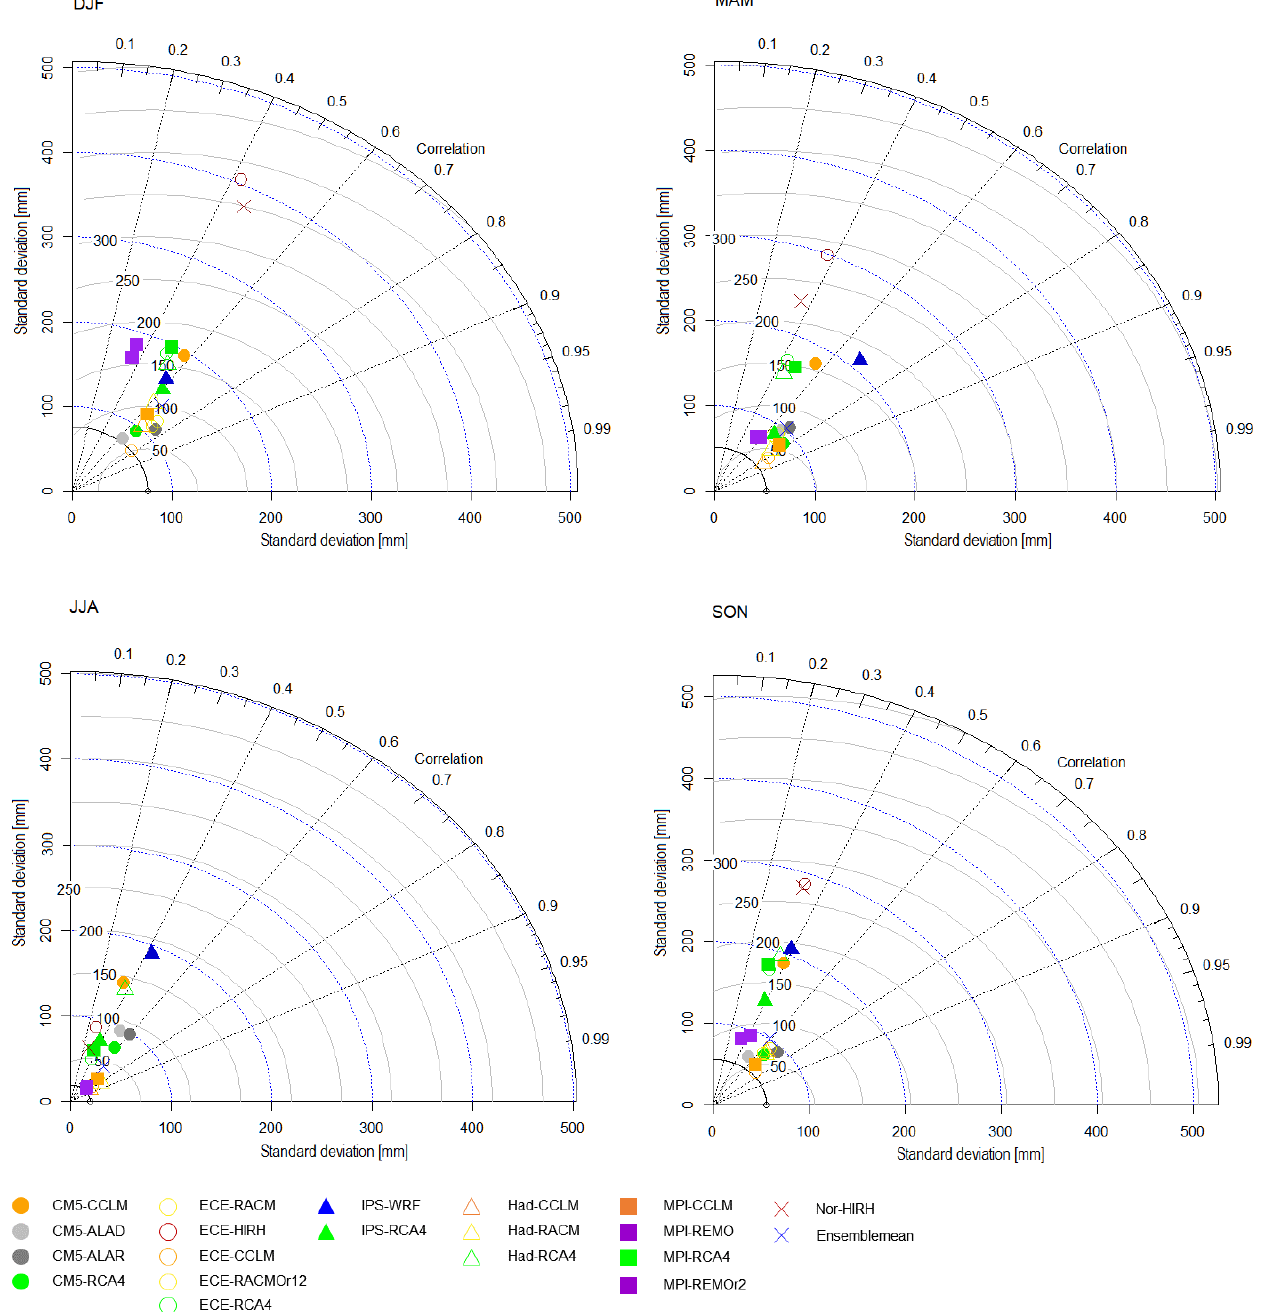
Figure 9. As Fig. 4 but for seasonal precipitation.